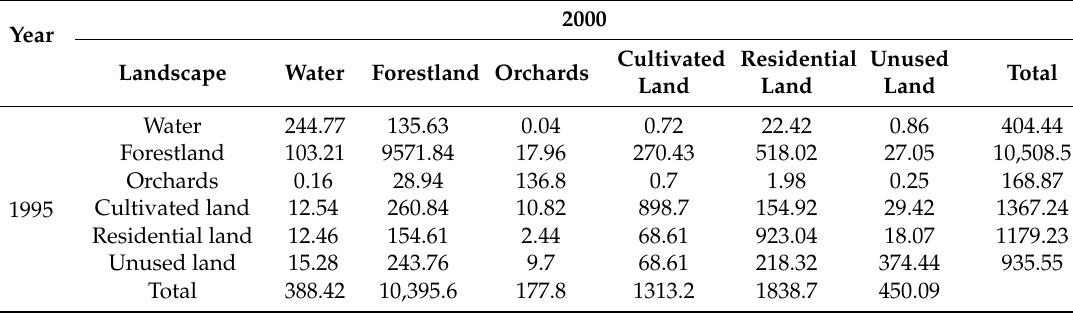
Table 19. The landscape transition matrix from 1995 to 2000 (km 2 ).